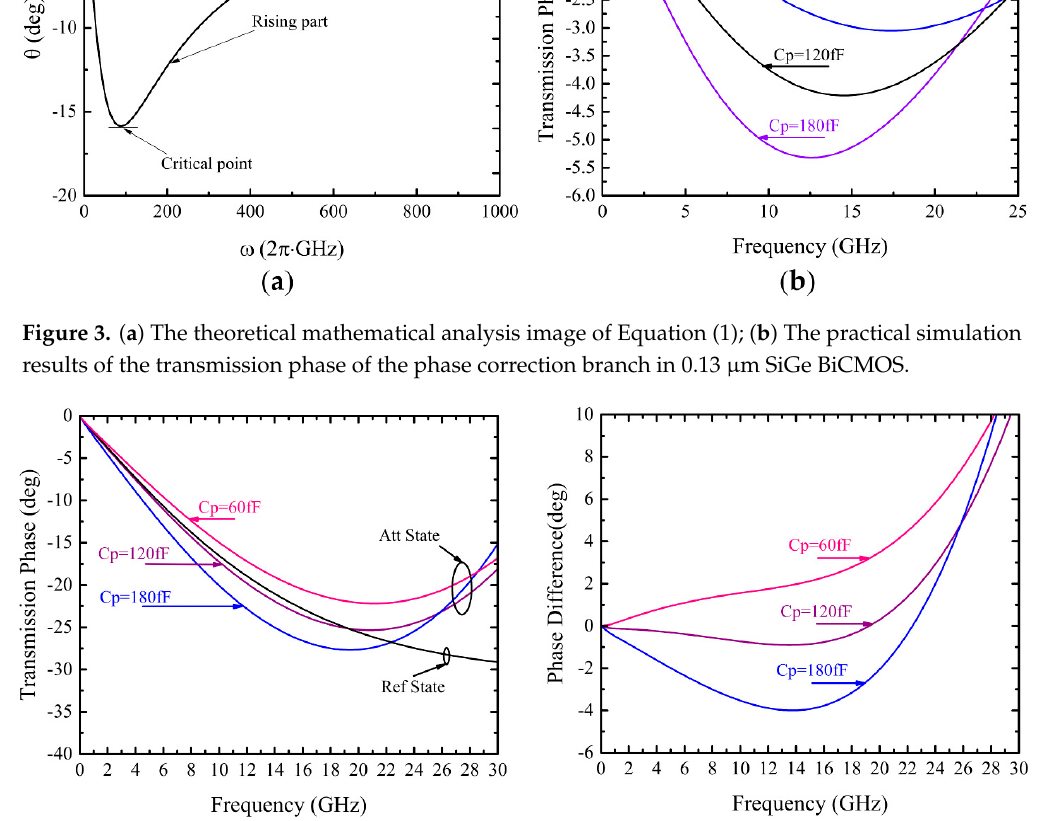
Figure 3. ( a ) The theoretical mathematical analysis image of equation (1); ( b ) The practical simulation results of the transmission phase of the phase correction branch in 0.13  m SiGe BiCMOS.